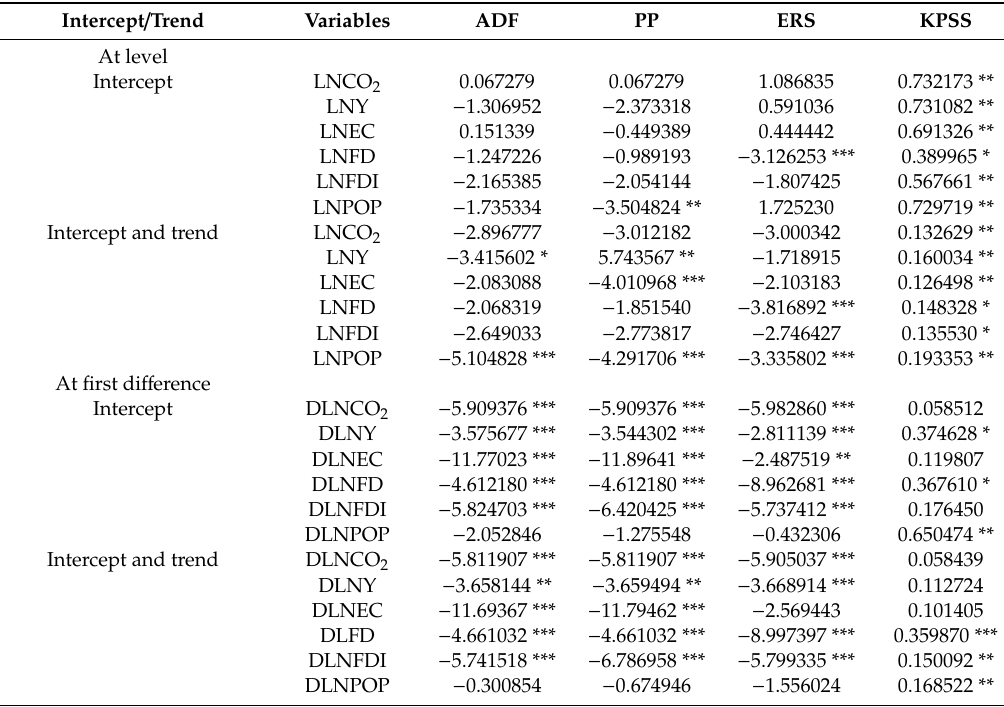
Table 3. Results of unit root tests.